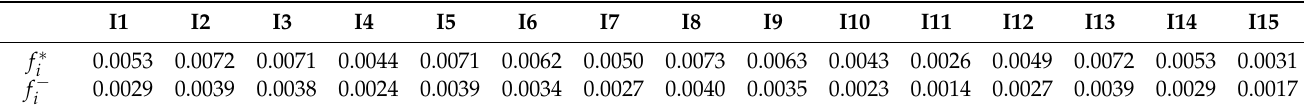
Table A5. Positive ideal solution and negative ideal solution of I4Es.